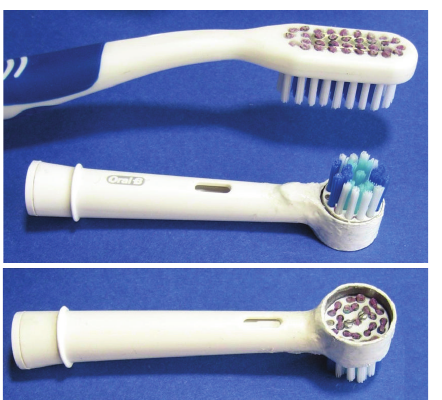
Figure 1: Manual toothbrush and electrical toothbrush head, modified with the proposed